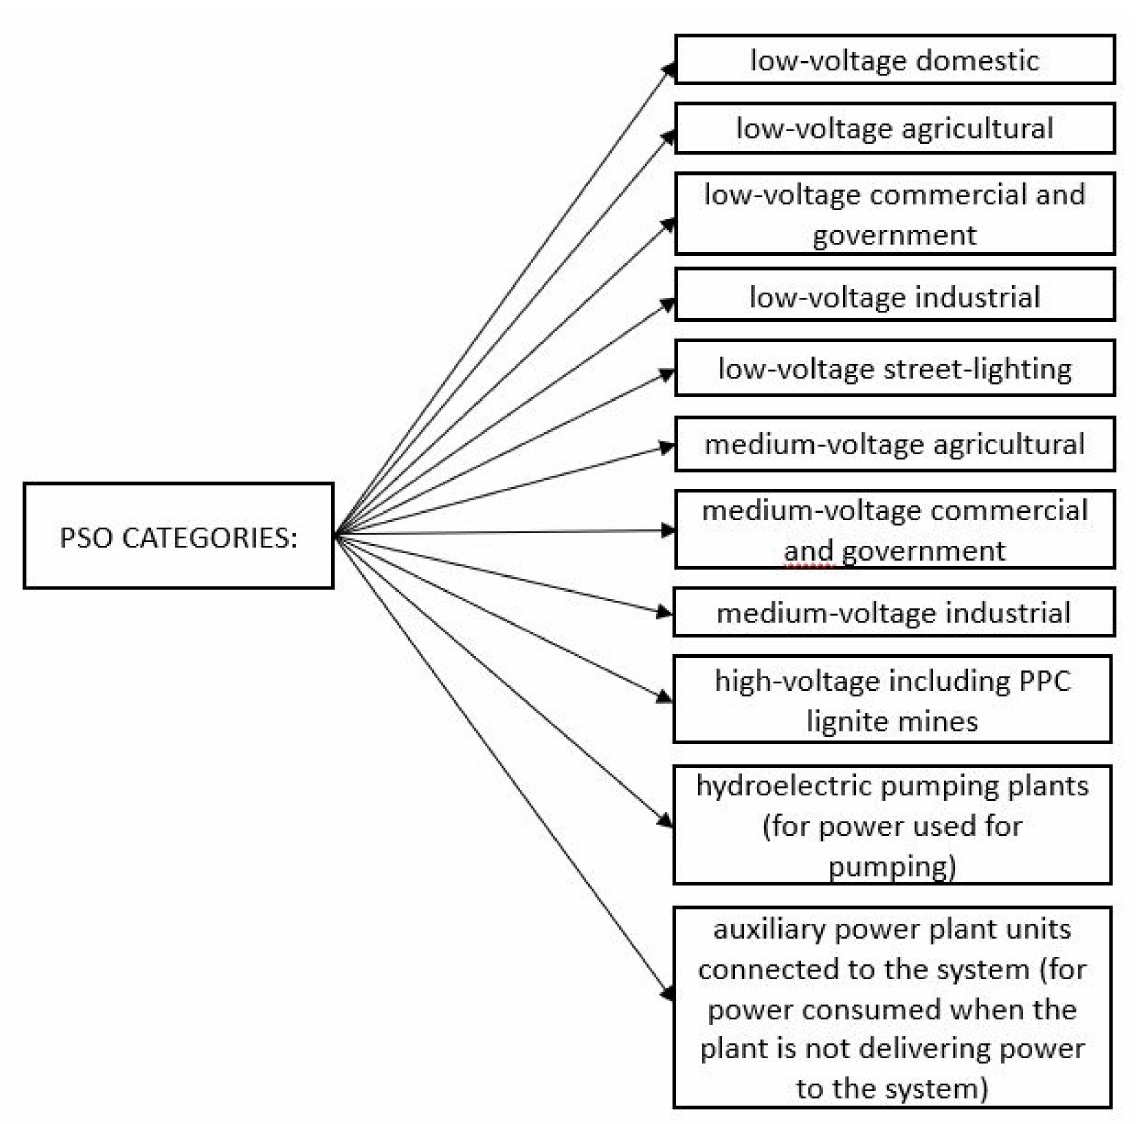
Figure A2. Payers of the PSO levy in Greece (designed by the authors, based on